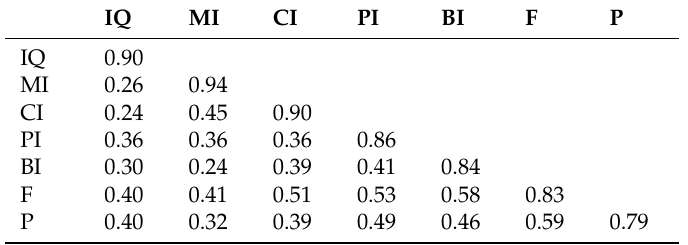
Table 3. Correlation coefficient matrix and square roots of AVEs (shown as diagonal elements).